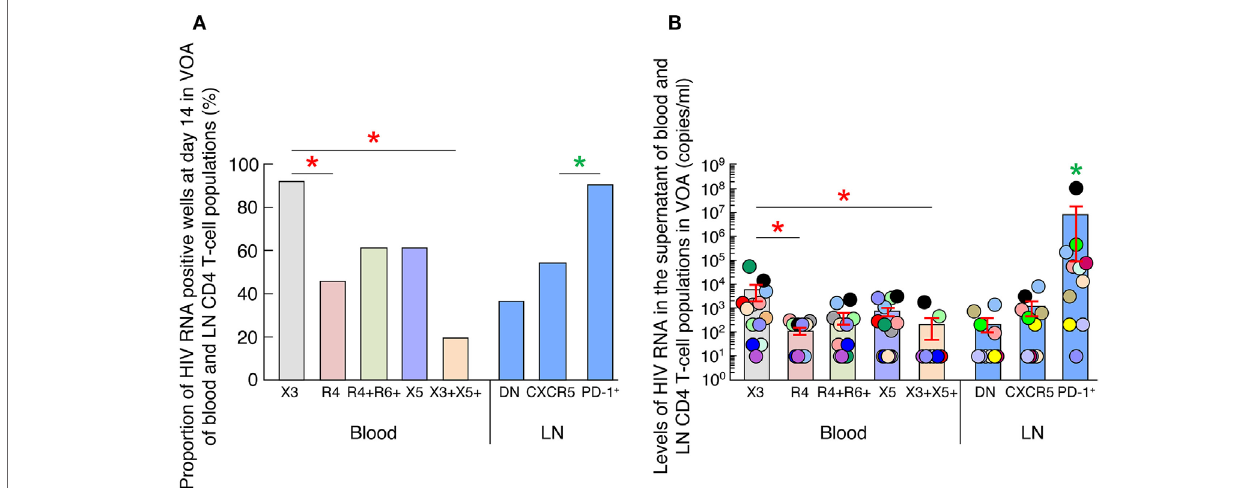
FigUre 2 | HIV replication and production of blood and lymph node (LN) memory CD4 T cell populations. (a) Proportion of HIV RNA positive wells among blood ( N = 13) and LN ( N = 11) memory CD4 T-cell populations at day 14 of virus outgrowth assay (VOA). Wells with detectable HIV-1 RNA ( ≥ 20 HIV-1 RNA copies/mL) were referred to as HIV-1 RNA-positive wells. (B) Levels of HIV-1 RNA in blood ( N = 13) and LN ( N = 11) memory CD4 T cell populations at day 14 of VOA. Undetectable values were arbitrarily defined as 10 HIV-1 RNA copies/mL. HIV-infected individuals are color coded (C). “X3” corresponds to blood CXCR3- expressing CD4 T cells; “R4” corresponds to blood CCR4-expressing CD4 T cells; R4 + R6 + corresponds to blood CCR4 + CCR6 + CD4 T cells; “X5” corresponds to blood CXCR5-expressing CD4 T cells; And X3 + X5 + corresponds to blood CXCR3 + CXCR5 + CD4 T cells. “LN” corresponds to lymph node. Red stars indicate statistical significance with in blood compartment ( P < 0.05). Green stars indicate statistical significance within LN compartment ( P < 0.05). Statistical significance ( P -values) was either obtained using two-tailed Chi-square analysis for comparison of positive proportions (a) or using one-way ANOVA (Kruskal–Wallis test) followed by Wilcoxon matched-pairs two-tailed signed rank test (B)